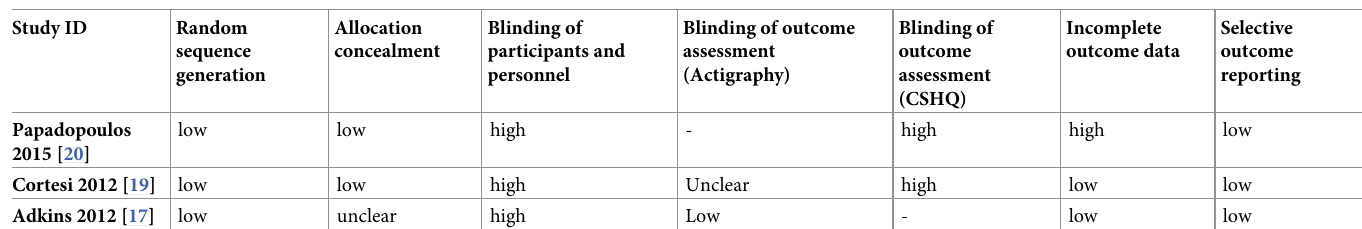
Table 2. Risk of